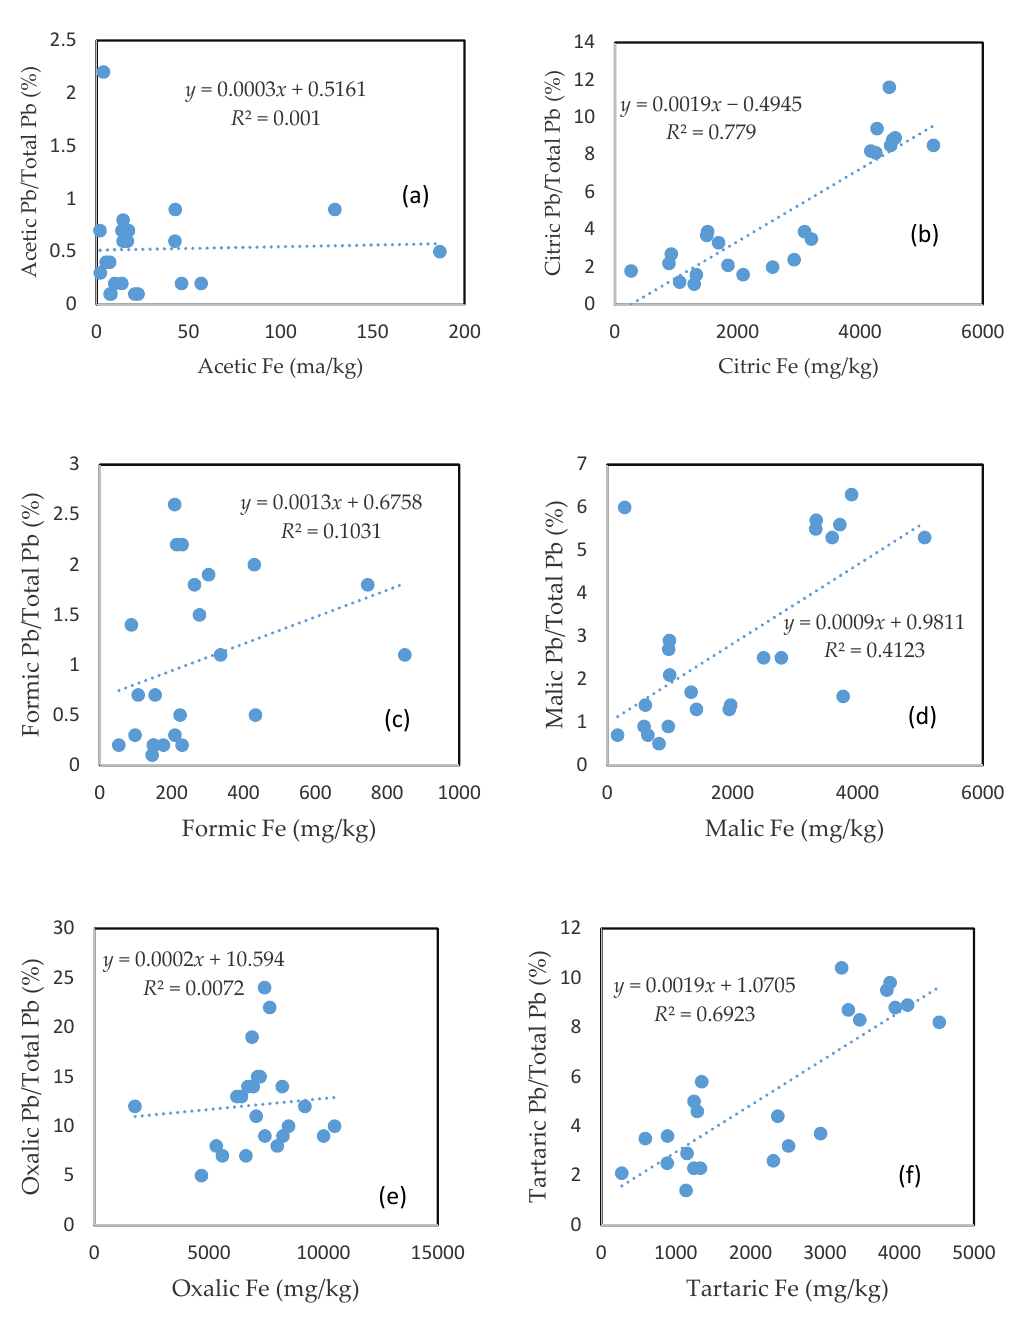
Figure 4. Relationship between the amount of Fe released from the soil and the rate of Pb mobilization in ( a ) acetic acid; ( b ) citric acid; ( c ) formic acid; ( d ) malic acid; ( e ) oxalic acid; and ( f ) tartaric acid treatments.